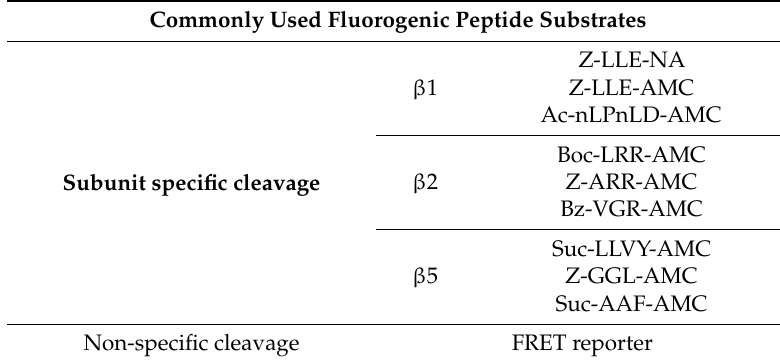
Table 1. Common fluorogenic peptide substrates used to assess proteasome activity.